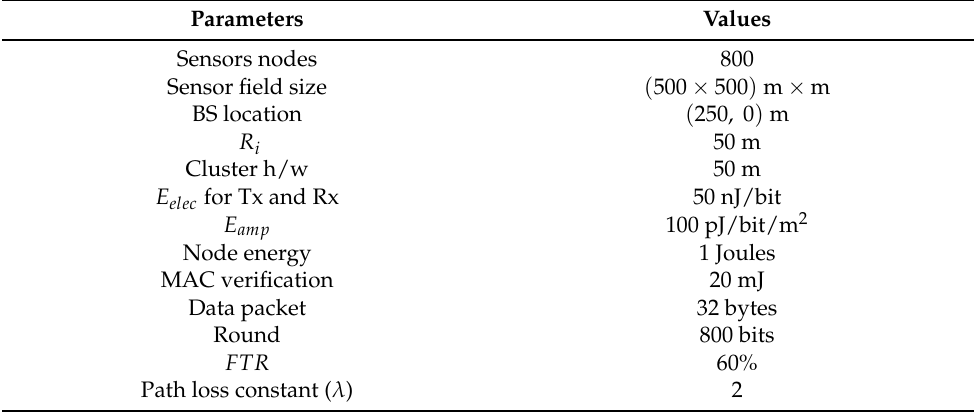
Table 1. Simulation parameters setup for